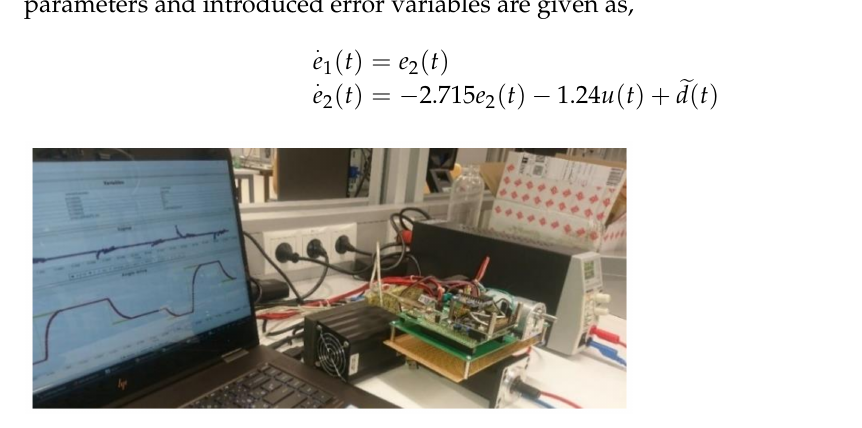
Figure 1. Position system.